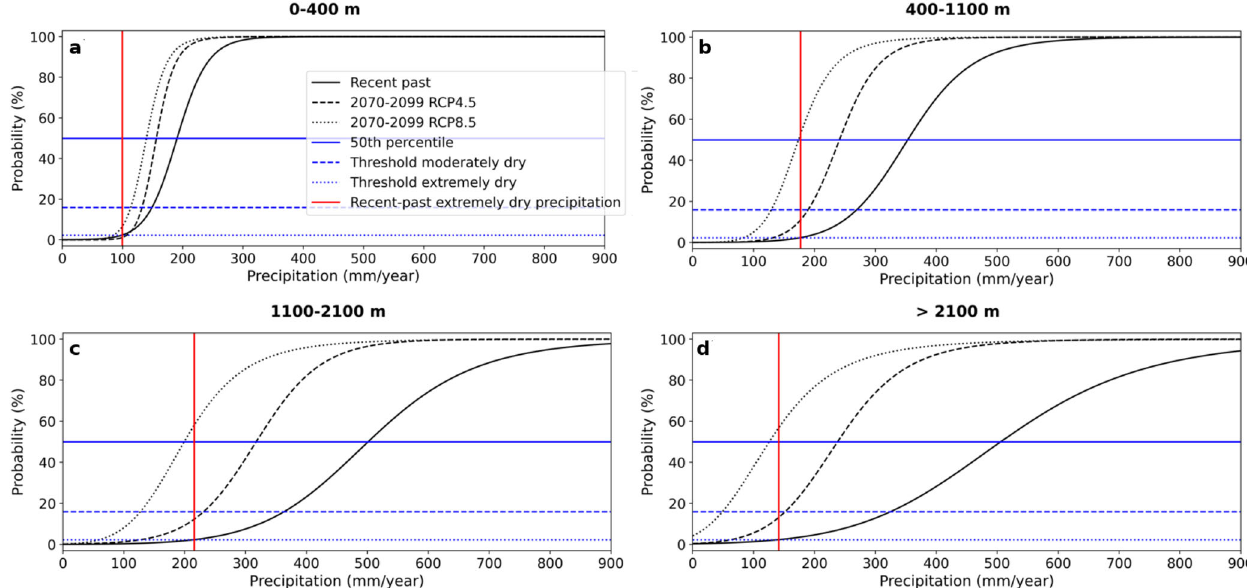
Fig. 2 Cumulative distribution functions for precipitation in the recent past and for future projections at different elevation levels. Twelve-month accumulated precipitation, in the MIROC-WRF model, at the four altitude intervals analyzed: a 0 – 400 m, b 400 – 1100 m, c 1100 – 2100 m, d >2100 m. The black solid curve represents the log-logistic Cumulative Distribution Functions (CDFs) for the reference period (1980 – 2009). The dashed lines represent CDFs fi tted to the precipitation data for the future period (2070 – 2099) for both emissions scenarios (RCP4.5 and RCP8.5). The blue lines are the values corresponding to the 50th percentile, moderately dry (SPI = – 1, 15.9th percentile) and extremely dry (SPI = – 2, 2.3th percentile). The red line indicates the precipitation value corresponding to “ extremely dry ” of recent past.